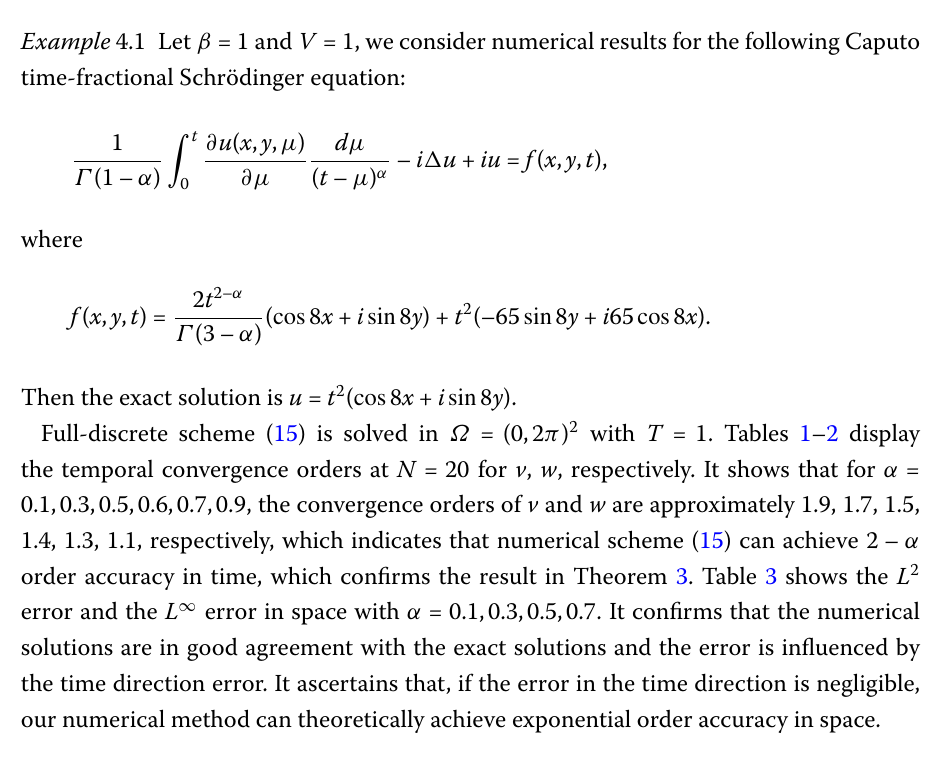
Table 1 Temporal convergence orders of v for Example 4.1